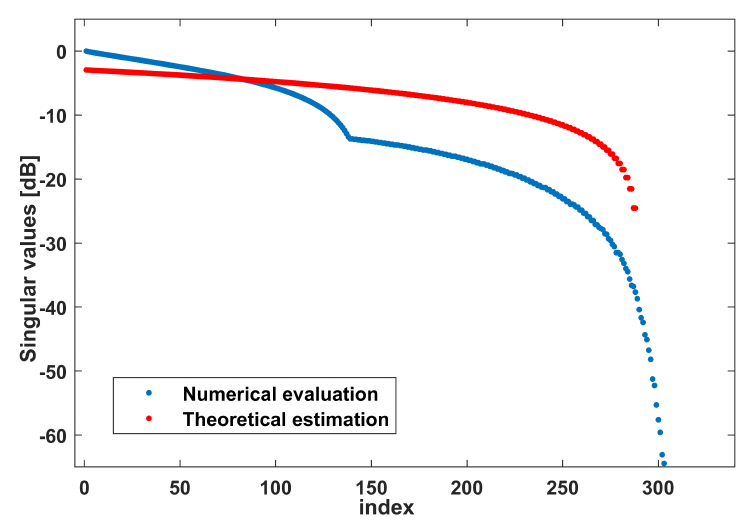
Figure 7. Singular values of A numerically computed, and their analytical estimation for the case a = 20 λ , z 1 = 5 λ , z 2 = 5.25 λ , X 1 = 20.75 λ ( η ( X 1 , z 1 ) = 0.9 ) , X 2 = 21.01 λ ( η ( X 2 , z 2 ) = 0.9 ) .